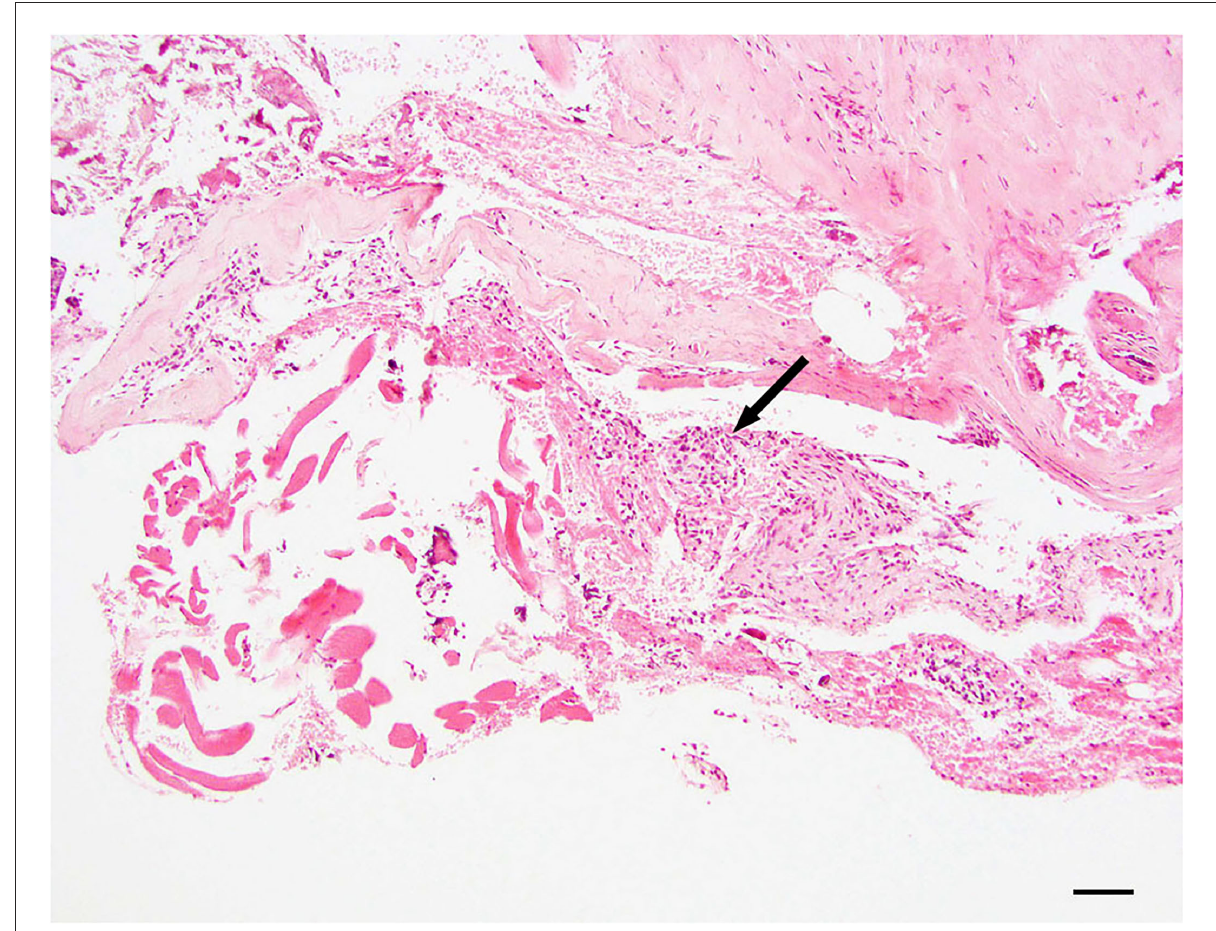
FIGURE2 Dural arachnoid hyperplasia; 20 × –Scale bar = 50 microns; Arrow indicates arachnoid hyperplasia.